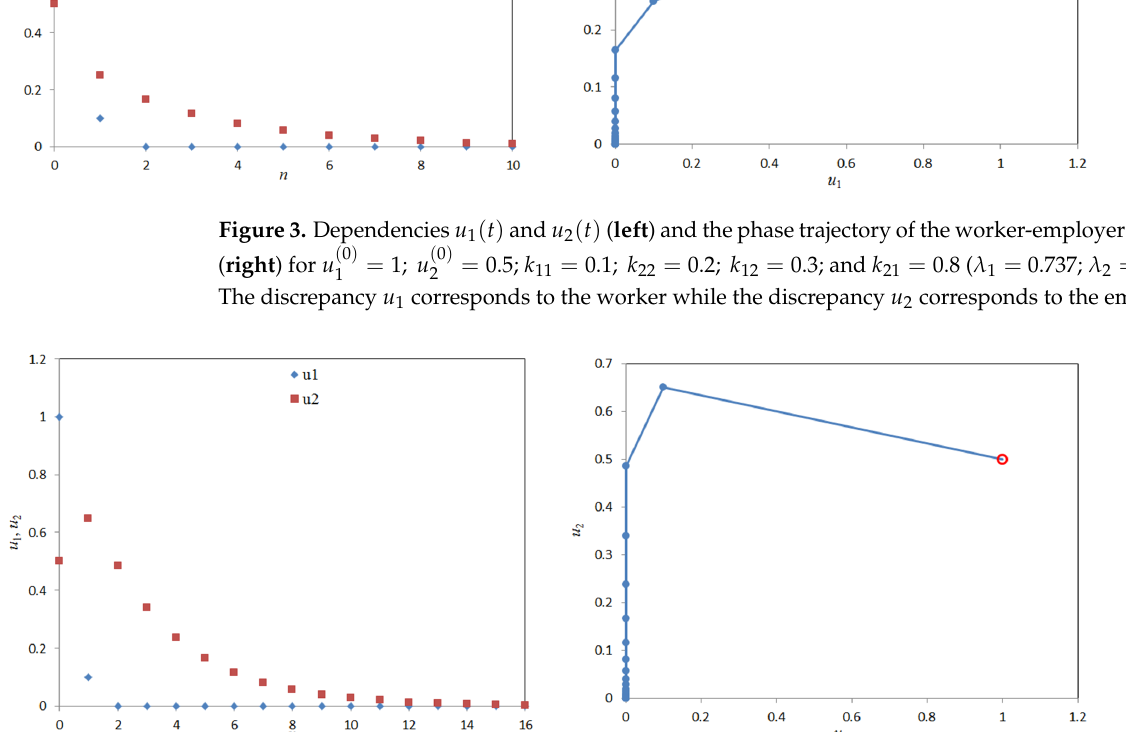
Figure 4. Dependencies 𝑢 (cid:2869) (cid:4666)𝑡(cid:4667) and 𝑢 (cid:2870) (cid:4666)𝑡(cid:4667) ( left ) and the phase trajectory of the worker ‐ employer conflict ( right ) for 𝑢 (cid:2869)(cid:4666)(cid:2868)(cid:4667) (cid:3404) 1; 𝑢 (cid:2870)(cid:4666)(cid:2868)(cid:4667) (cid:3404) 0.5; 𝑘 (cid:2869)(cid:2869) (cid:3404) (cid:3398) 0.3; 𝑘 (cid:2870)(cid:2870) (cid:3404) 0.2; 𝑘 (cid:2869)(cid:2870) (cid:3404) 0.3; and 𝑘 (cid:2870)(cid:2869) (cid:3404) 0.8 ( 𝜆 (cid:2869) (cid:3404) 0.5; 𝜆 (cid:2870) (cid:3404) 0.4). The discrepancy 𝑢 (cid:2869) corresponds to the worker while the discrepancy 𝑢 (cid:2870) corresponds to